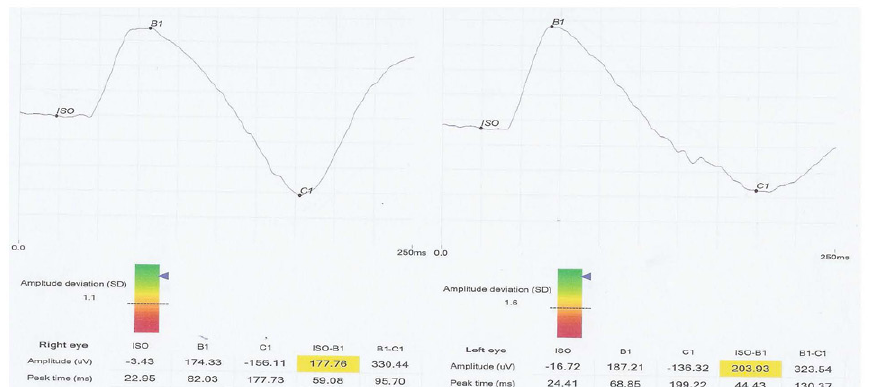
Figure 1: An example of an ERG recording obtained during this study. Included are the ERG plots and the amplitudes and implicit times for the B and C peak/troughs for each eye. The position of the B